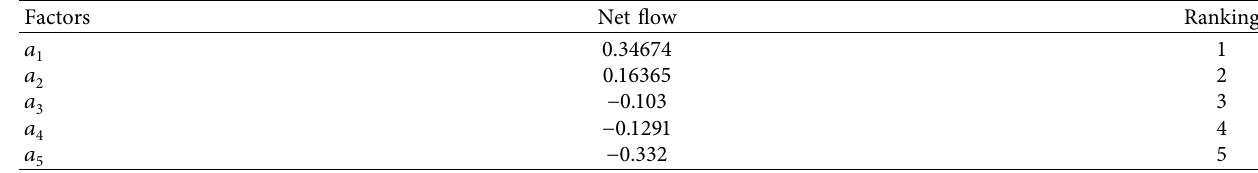
Table 18: Net flow and ranking of factors.